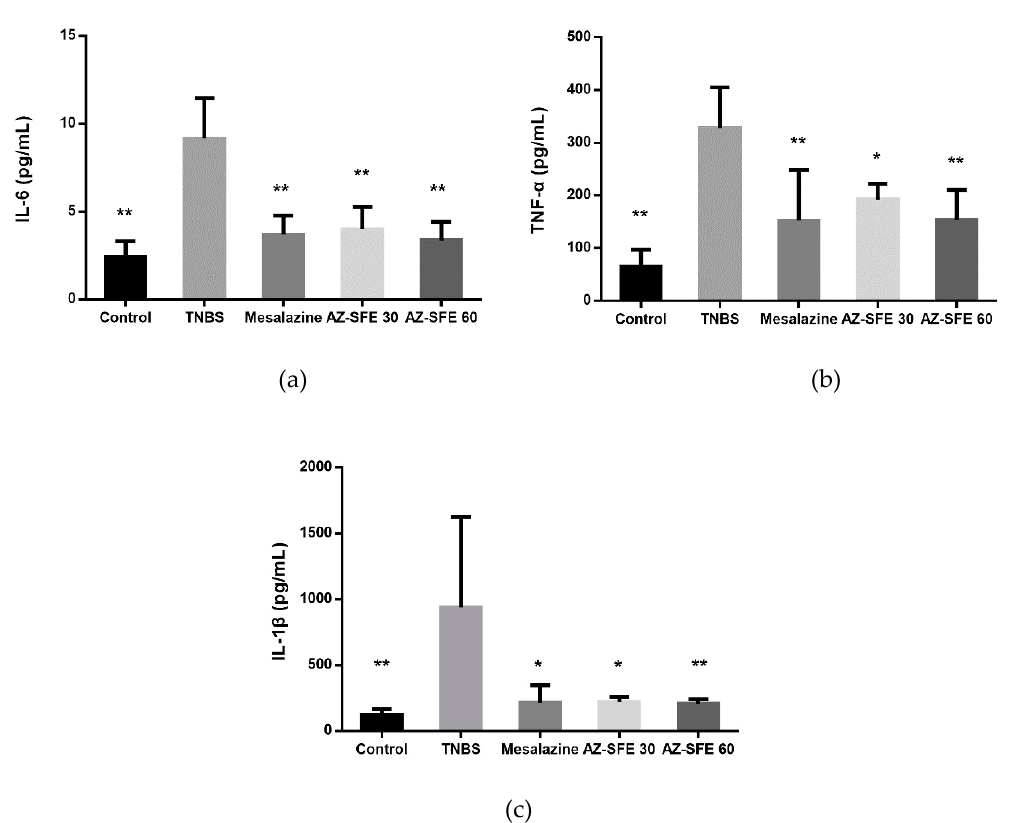
Figure 8. Effects of AZ-SFE (30 and 60 mg/kg) and mesalazine (400 mg/kg) on production of pro-inflammatory cytokines in serum of TNBS-induced colitis in rats. ( a ) IL-6. ( b ) TNF- α . ( c ) IL-1 β . Data are presented as mean ± SD of 6 rats per group. * p < 0.05 and ** p < 0.01 versus TNBS group.